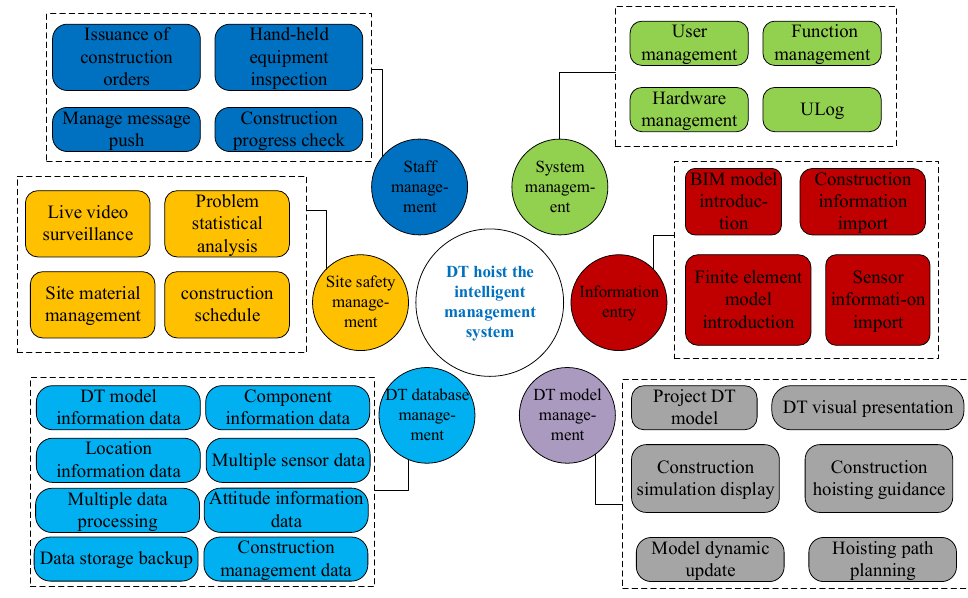
Figure 13. Analysis of system platform functional architecture.